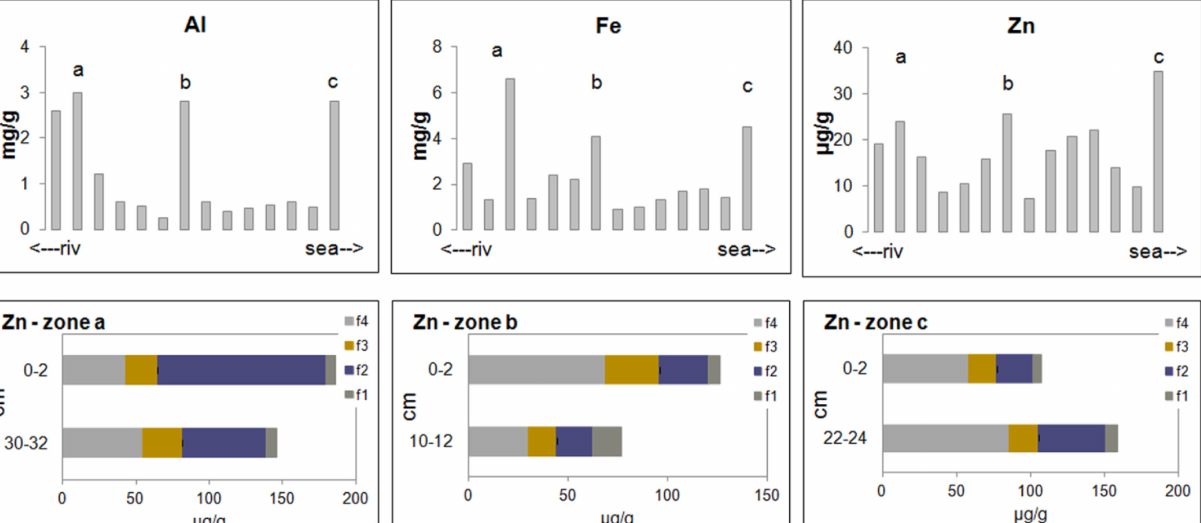
Figure 11. Upper panel: the distribution of metals extracted by 0.5 N HCl of the surface sediments of the Acheloos estuary and their relative enrichment in the upper boundary of SW ( a ), the sill bar ( b ) and the offshore station ( c ); Lower panel: vertical distributions of f1 (easily exchangeable), f2 (inorganic), f3 (organic), and f4 (residual) fractions of Zn extracted by SES (1) of Table 1 in sediments of short cores obtained from zones ( a ), ( b ), and ( c